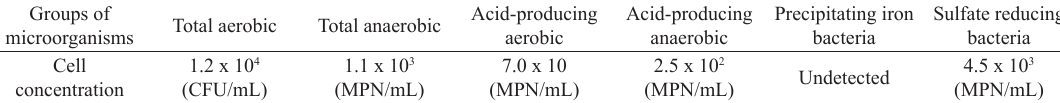
Table 2. Planktonic microorganisms in the produced water 31 .